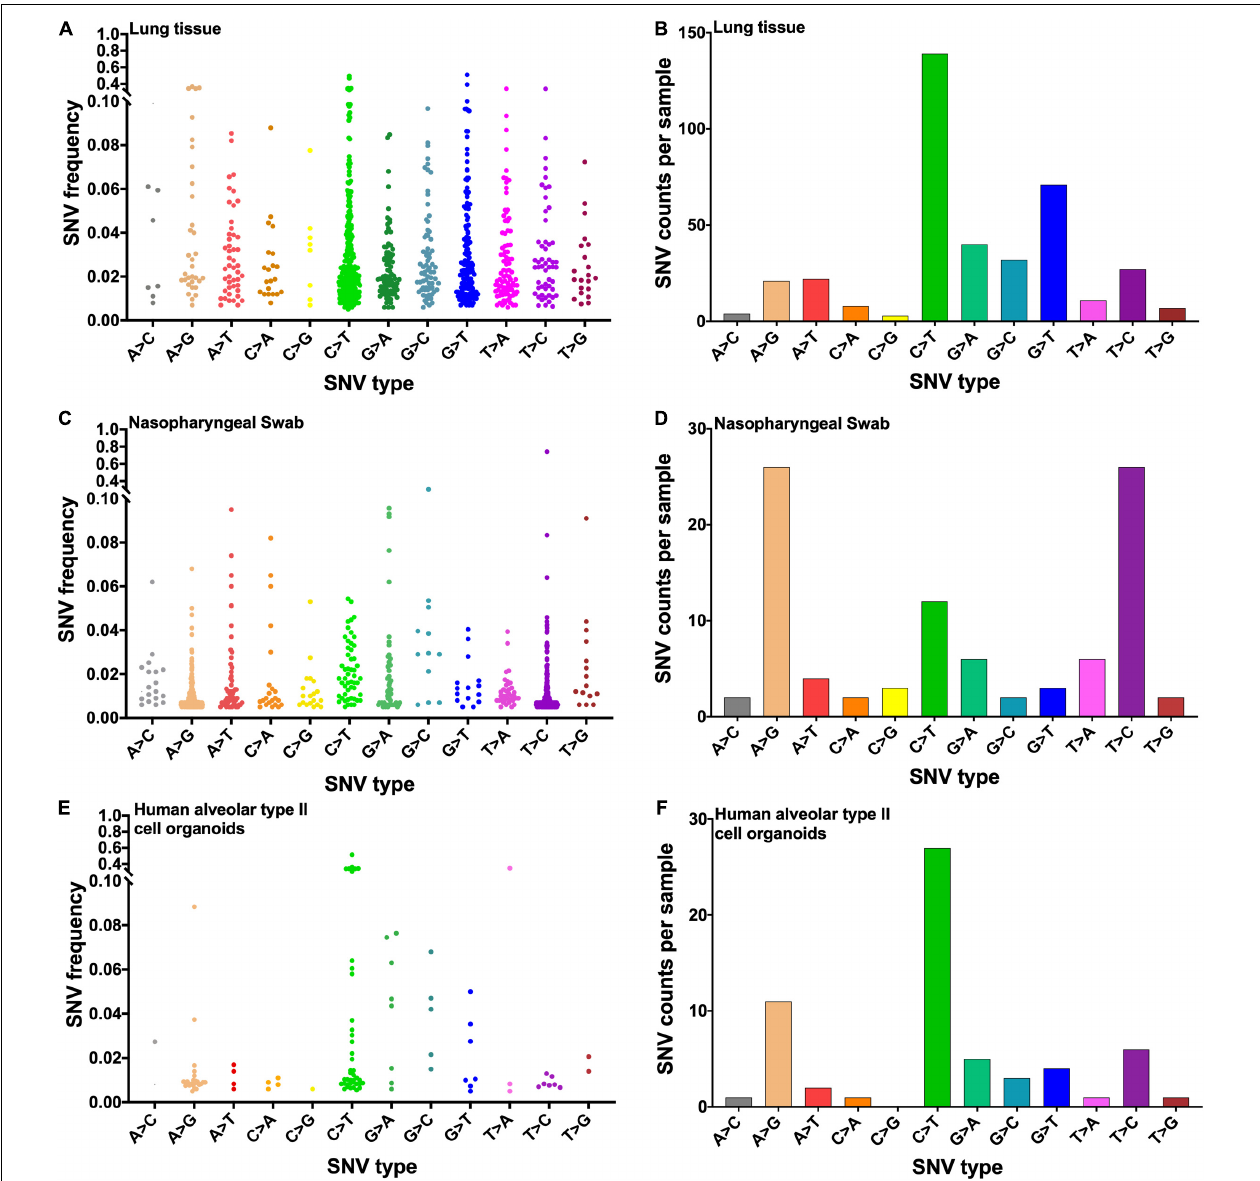
FIGURE 6 | RNA mutation in the transcriptome of SARS-CoV-2. (A) Distribution of all SNV types from lung tissues. (B) Different SNV counts per sample from lung tissues. (C) Distribution of all SNV types from nasopharyngeal swabs. (D) Different SNV counts per sample from nasopharyngeal swabs. (E) Distribution of all SNV types from human alveolar type II cell organoids. (F) Different SNV counts per sample from human alveolar type II cell organoids. SARS-CoV-2, severe acute respiratory syndrome coronavirus 2; SNV, single-nucleotide